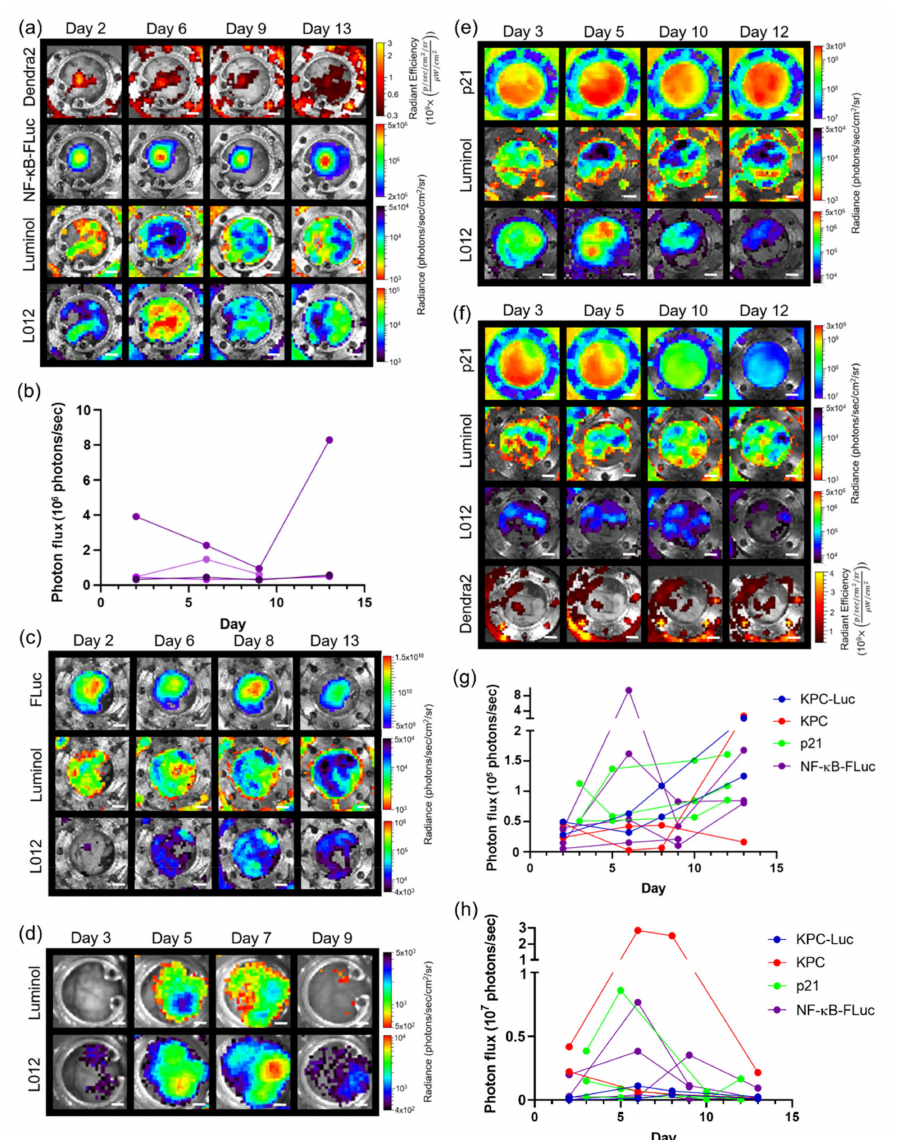
Figure 5. In vivo bioluminescence unmixing in wild type animals with a pancreas window chamber. ( a ) Representative unmixed in vivo pancreas window chamber macro-imaging over time of Pan02 tumor growth; Pan02 tumor cells imaged using Dendra2 fluorescence ( λ ex = 409 nm, λ em = 507 nm) and tumor NF- κ B transcriptional activation monitored by FLuc bioluminescence following D-luciferin i.p. injection. ( b ) Corresponding longitudinal bioluminescence quantification as a function of time of NF- κ B transcriptional activation in pancreas window chamber animals with Pan02 NF- κ B-FLuc Dendra2 reporter cells ( n = 4 animals); each colored line corresponds to the NF- κ B bioluminescent reporter output in an individual animal. In vivo bioluminescence unmixing in spontaneous pancreas ductal adenocarcinoma animal model. Representative unmixed bioluminescence images of abdominal window chambers (implanted at week 14) visualizing the pancreas in ( c ) KPC-Luc and ( d ) KPC control animals. Pancreas tumor growth monitored by FLuc bioluminescence following D-luciferin i.p. injection. In vivo bioluminescence unmixing in transgenic p21-FLuc pancreas window chamber animals ( e ) without ( n = 2 animals) and ( f ) with Pan02 Dendra2 reporter cells ( n = 2 animals). Reporter p21 activation is monitored by FLuc bioluminescence following D-luciferin injection. Innate immune cell infiltration imaged by bioluminescence using luminol and L-012. Longitudinal bioluminescence quantification as a function of time of ( g ) luminol and ( h ) L-012 of pancreas window chamber animals. Scale bar represents 2